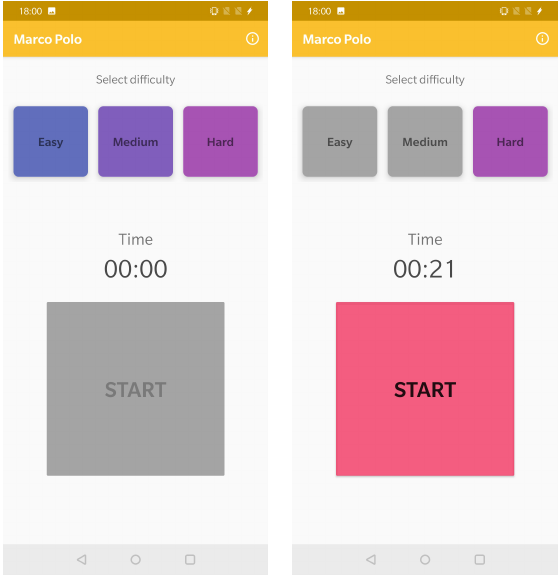
Figure 8. Overview of the “Marco Polo”